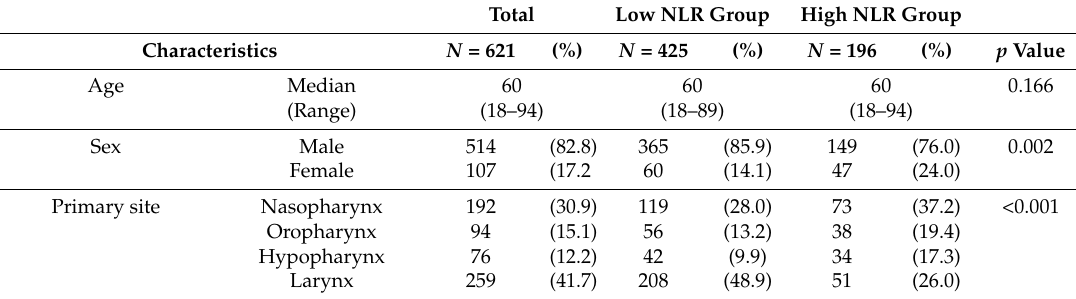
Table 1. Patient